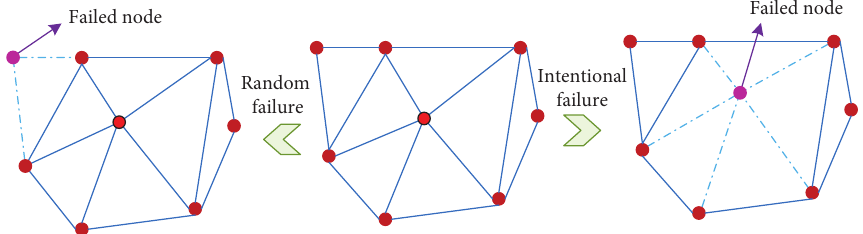
Figure 2: Network failure schematic